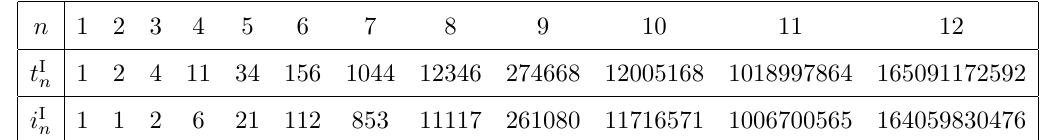
Table 3 . Number of inequivalent graphs on n nodes t I classes), for n ≤ 12 . Number of inequivalent indecomposable graphs i I and A001349